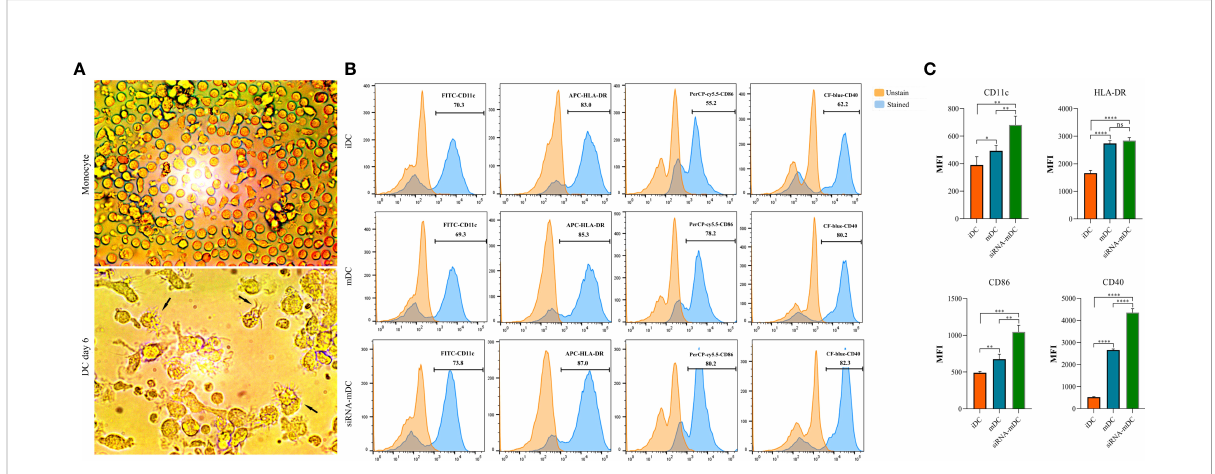
FIGURE 2 Morphological and phenotypical characterization of DCs. (A) Morphological changes during in vitro culture of adherent monocytes and differentiated DCs. Arrows indicate DCs with typical morphology having sharp dendrites. (B) Phenotypic characterization of iDCs, mDCs, and CTLA-4-silenced mDCs quanti fi ed by fl ow cytometry for the expression of surface markers, including CD11c, HLA-DR, CD86, and CD40. Results are expressed as the percentage of stained cells for these markers ( fi gures (A, B) provided as representative of all samples). (C) The expression levels of CD11c, HLA-DR, CD86, and CD40 between iDCs, mDCs, and CTLA-4-silenced mDCs are represented as MFI. (ns, not signi fi cant, *P ≤ 0.05, **P ≤ 0.01, ***P ≤ 0.001, and ****P ≤ 0.0001). DCs, dendritic cells; CTLA-4, Cytotoxic T-lymphocyte-associated protein-4; iDCs, Immature dendritic cells; mDCs, Tumor cell lysate-loaded mature dendritic cells; siRNA-mDCs, CTLA-4-silenced mDCs; HLA-DR, Human leukocyte antigen-DR isotype; MFI, Median fl uorescence